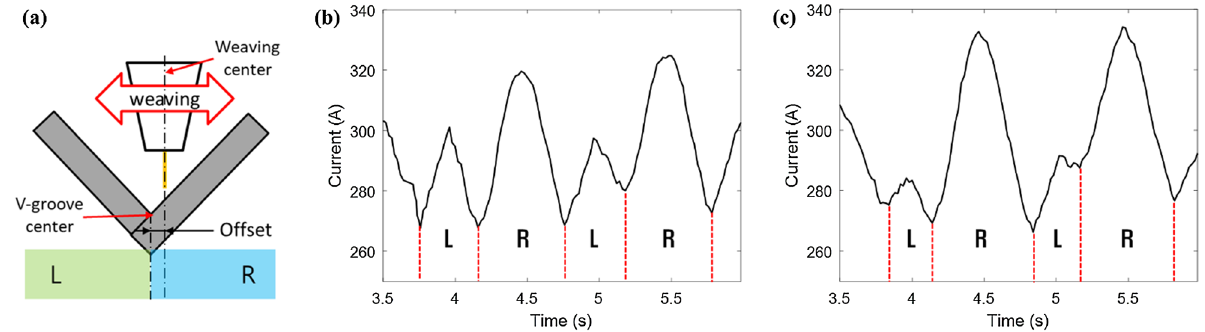
Figure 7. Area difference between the L area and R area during weaving. ( a ) Experiment schematic; ( b ) offset = 1 mm (area difference = 3000); ( c ) offset = 2 mm (area difference = 6000).